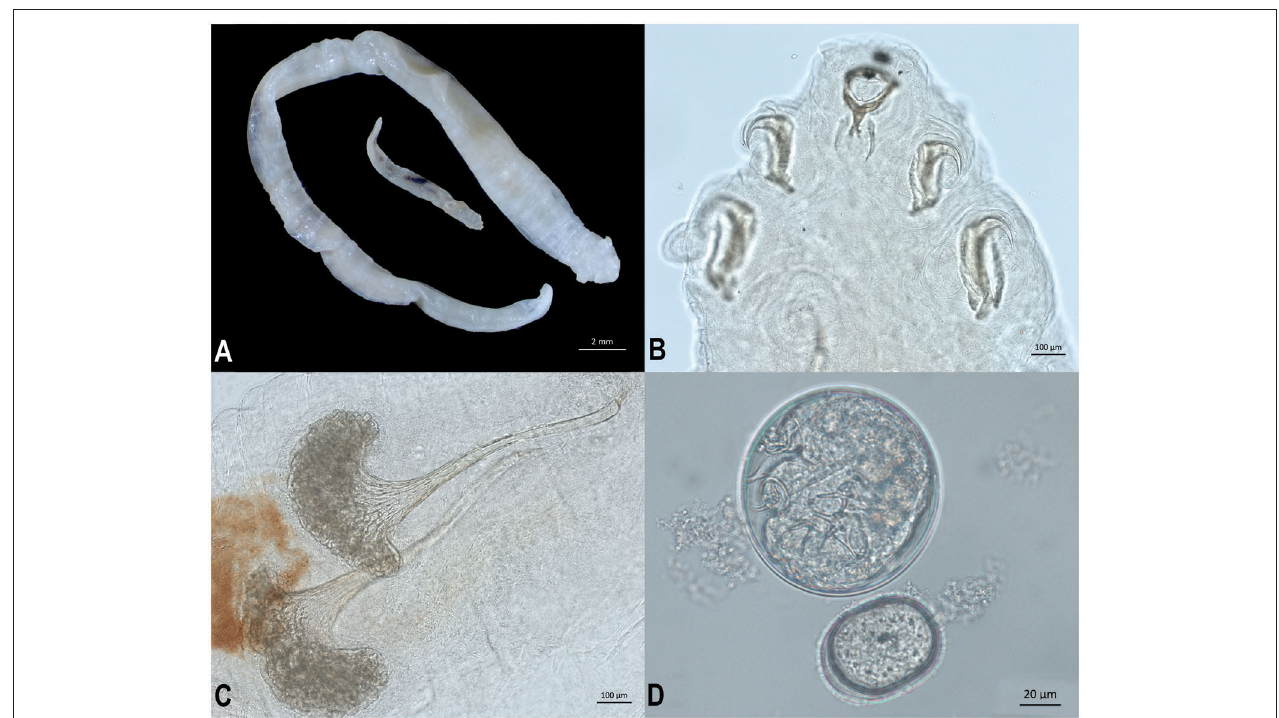
FIGURE 3 | Life stages and morphological characteristics of Raillietiella orientalis pentastomes recovered from the lungs of a banded water snake ( Nerodia fasciata ). (A) Ethanol-fixed male (smaller) and female (larger) R. orientalis adults. (B) Male R. orientalis anterior hooks and buccal cadre. (C) Spicules from male R. orientalis . (D) Egg recovered from uterus of gravid female R. orientalis